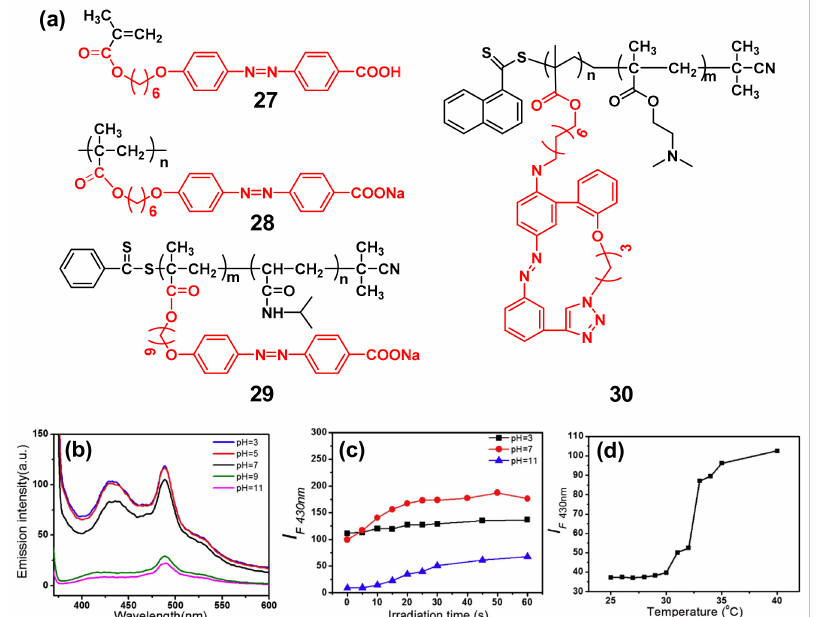
Figure 14. ( a ) The molecular structure of azobenzene-containing polymers 27 – 30 . ( b ) The change in fluorescence at 430 nm upon UV irradiation (365 nm, 70 mW/cm 2 ). ( c ) The fluorescence emission spectra of 29 (5 mg/mL, λ ex =360 nm, slit:10 nm) at different pH values. ( d ) The change in fluorescence of 29 at different temperatures ( λ ex =360 nm, slit 10 nm). ( b – d ) were reproduced with permission from [70]. Copyright 2016 Elsevier.